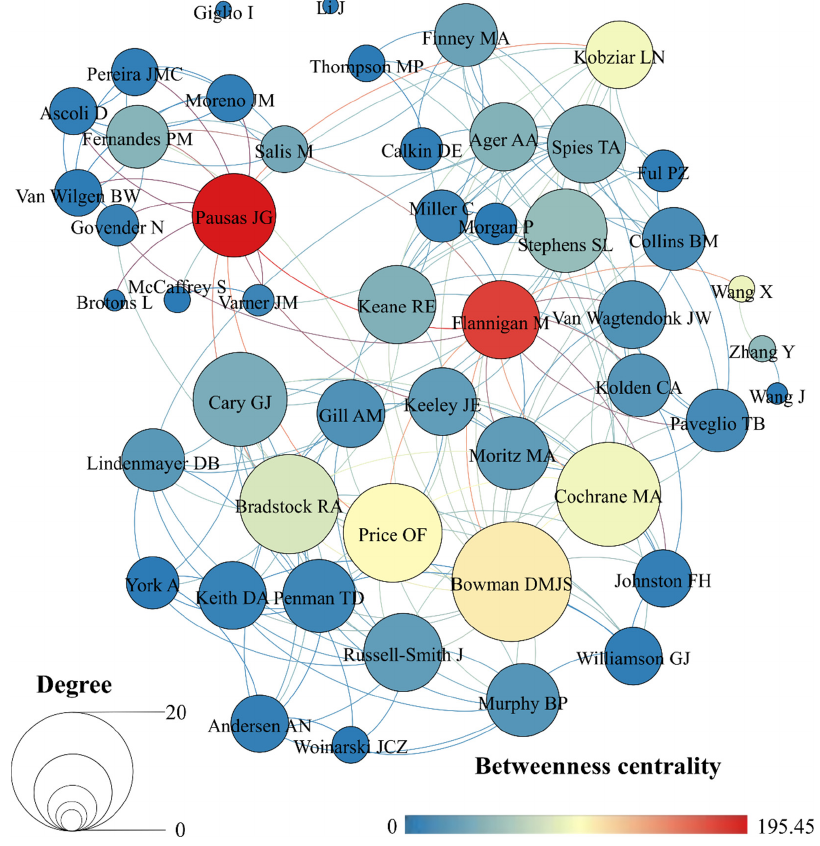
Figure 7. Collaboration network of the 50 authors with most collaborations in fire-management research according to Scopus (1973–2021).